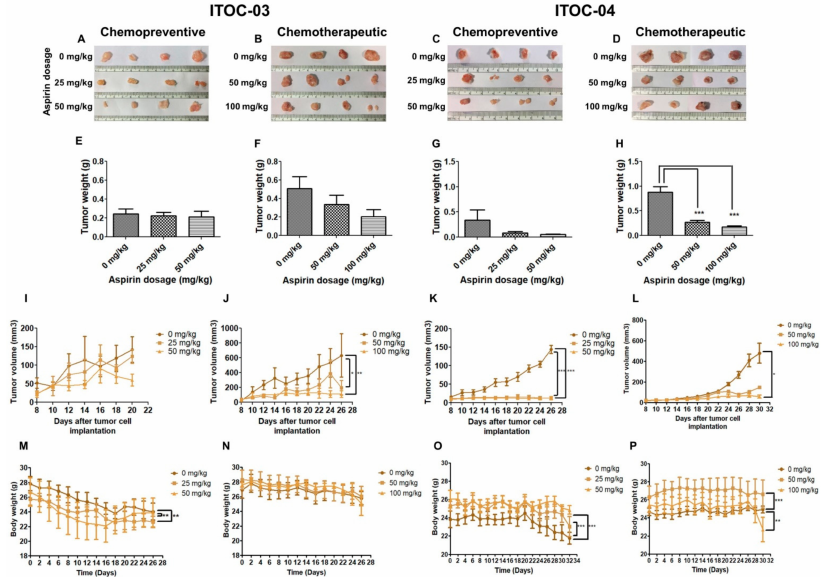
Figure 5. Chemopreventive and chemotherapeutic effect of aspirin on GB-SCC xenografts. ( A – D ) Photographs of ITOC-03 and ITOC-04 untreated and aspirin-treated tumor xenografts. The effect of different doses of aspirin on ( E – H ) Tumor weight ( I – L ) Tumor volume and ( M – P ) Body weight of mice. One-way ANOVA and Bonferroni post-test were used for statistical analysis, n = 4/group, * p < 0.05, ** p < 0.01, *** p < 0.001.